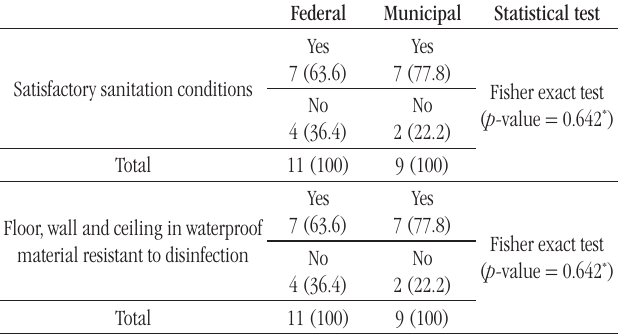
figurE − CLA classification by the public sphere CLA: clinical laboratory